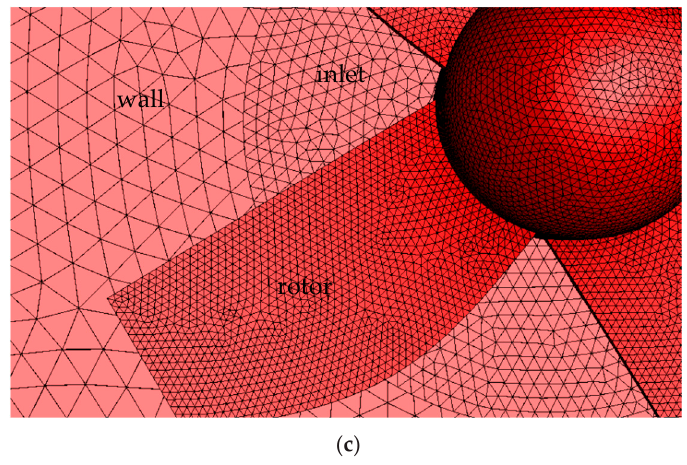
Figure 7. Passive rotor grid model: ( a ) The mesh on the rotor surface, ( b ) The detail of the mesh on one of the blades (dotted line zone in Figure 5a), ( c ) The detail of the mesh of the rotor, the inlet, and the walls.